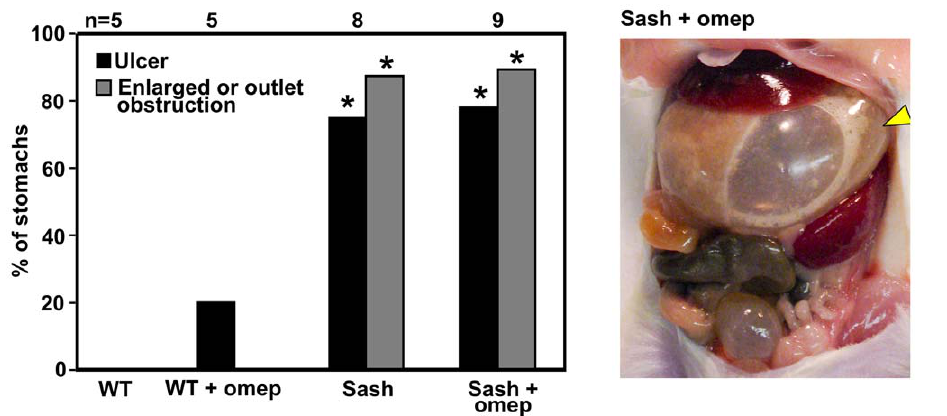
Figure 5. Acid inhibition with the proton pump inhibitor omeprazole does not protect mast cell-deficient mice from development of NSAID-induced peptic ulceration or gastric outlet obstruction. * indicates p , 0.05 compared with WT mice treated with piroxicam alone. Gastric distension by large amounts of gas is readily apparent (arrowhead) in this gross photograph of an omeprazole-reated Sash mouse on day 5 of piroxicam treatment.